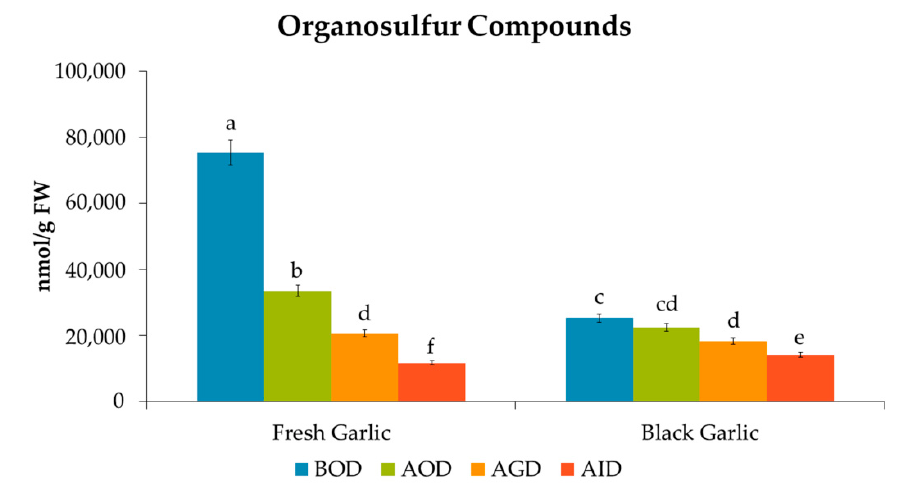
Figure 5. Quantities of total organosulfur compounds during the in vitro gastrointestinal digestion. Data are expressed as nmol/g FW as mean values ( n = 6). Different letters (one ‐ way ANOVA) denote statistically significant differences between the stages of simulated gastrointestinal digestion ( p ‐ value < 0.05). (BOD, Before Oral Digestion; AOD, After Oral Digestion; AGD, After Gastric Digestion; AID, After intestinal digestion).